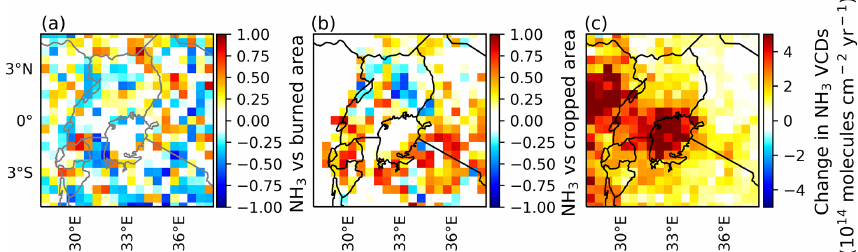
Figure 6. Changes in NH 3 VCDs and their relationship with burned area and cropped area over the Lake Victoria region for the 2008 through 2018 period. (a) Correlation coefficients for the relationship between NH 3 VCDs and burned area. (b) Correlation coefficients for the relationship between NH 3 VCDs and cropped area, including mosaics of crops and natural vegetation cover. (c) Changes in NH 3 VCDs.